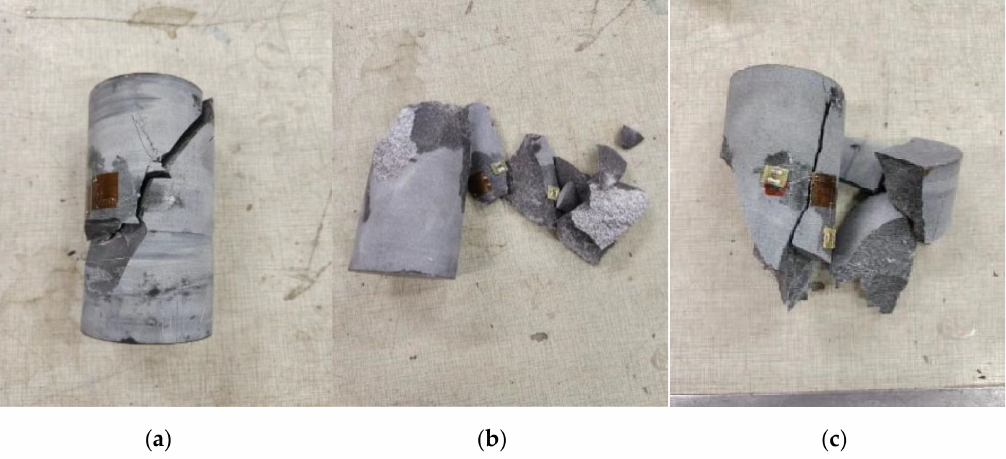
Figure 3. Rock failure mode of uniaxial compression test. ( a ) Sample A-1; ( b ) Sample A-2; ( c ) Sample A-3.